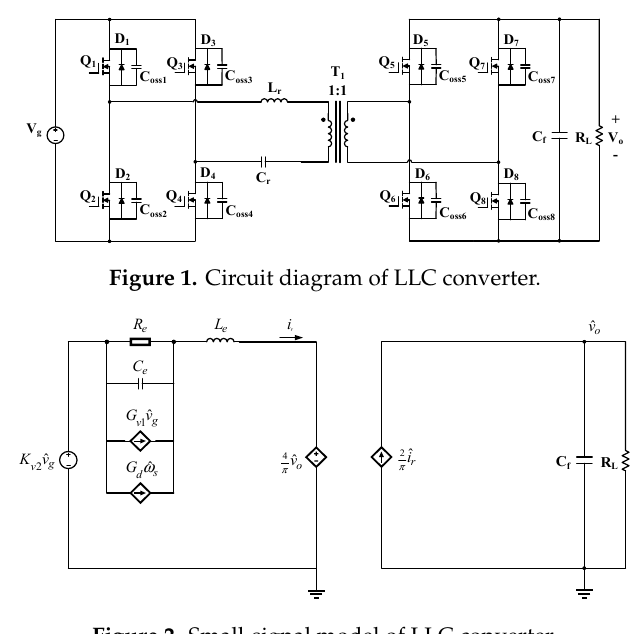
Figure 2. Small-signal model of LLC converter.